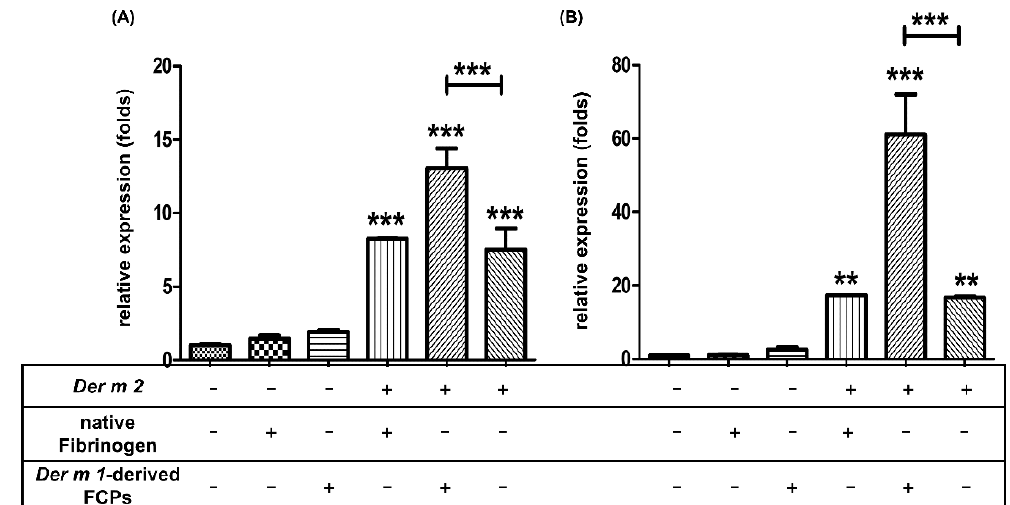
Figure 8. The proteolytic cleavage of fibrinogen by recombinant Der m 1 protease. ( A ) The fibrinogen (5 mg/mL) was incubated with Der m 1 (+: 0.1 mg/mL; ++: 0.2 mg/mL; +++: 1.0 mg/mL) and/or crude Der m (0.1 mg/mL) at 37 °C for the indicated time (0, 6, and 24 h) and further analyzed by SDS- PAGE. ( B ) The quantity of α , β , and γ chains remaining in the FCPs mixture showing Der m 1 - mediated degradation of fibrinogen. ( C ) Fibrinogen composed of three different polypeptide chains including α , β , and γ chains. FCPs: Fibrinogen cleavage products.